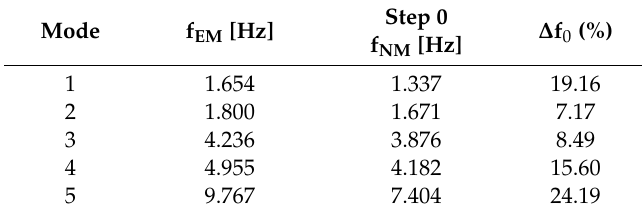
Table 1. Comparison between the Experimental Model (EM) and Numerical Model (NM) frequencies at step 0.